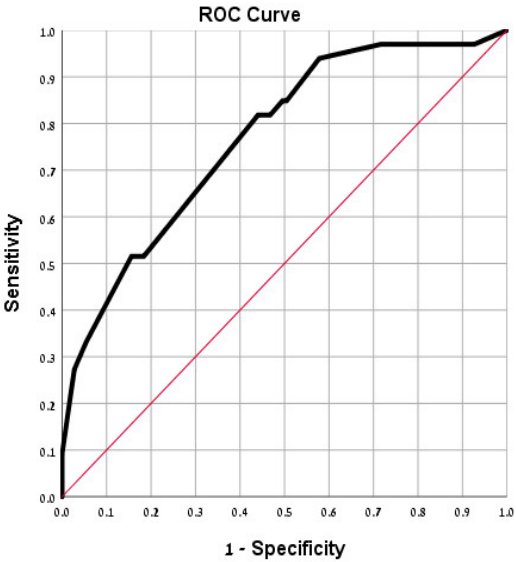
Figure 2. Receiver operating curve (ROC) analysis for ‘goodness-of-fit’ of the found model for implant success. The area under the ROC curve (AUC) is significant (p < 0.0001).